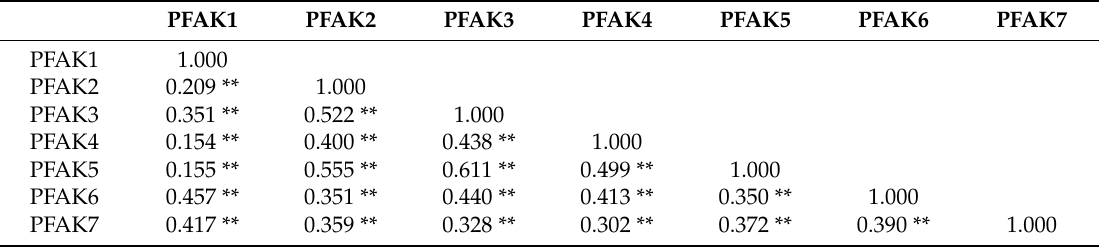
Table 3. Correlation between the factors.